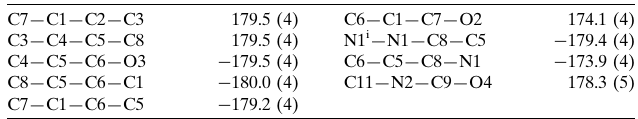
Selected torsion angles ( (cid:3) ).